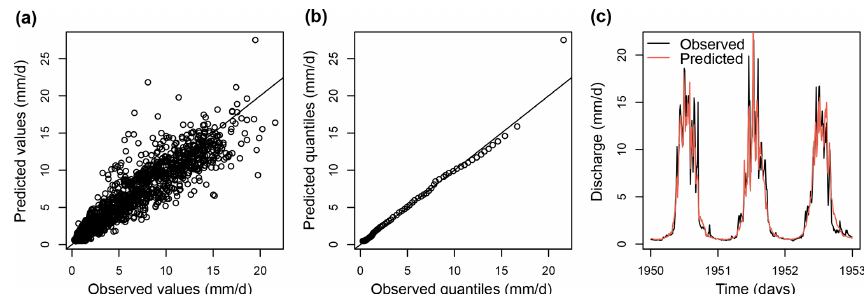
Figure 4. Evaluation of the GAM model fitted using natural streamflow data of the Dranse de Bagnes (before reservoir construction 1911– 1956) and used to predict streamflow with precipitation, temperature, day of year, and glacier mass balance changes as predictors. (a) Ob- served vs. predicted values (1911–1956), (b) Q–Q plot of observed vs. simulated quantiles (1911–1956), and (c) observed vs. predicted time series (3 years; 1950–1953).